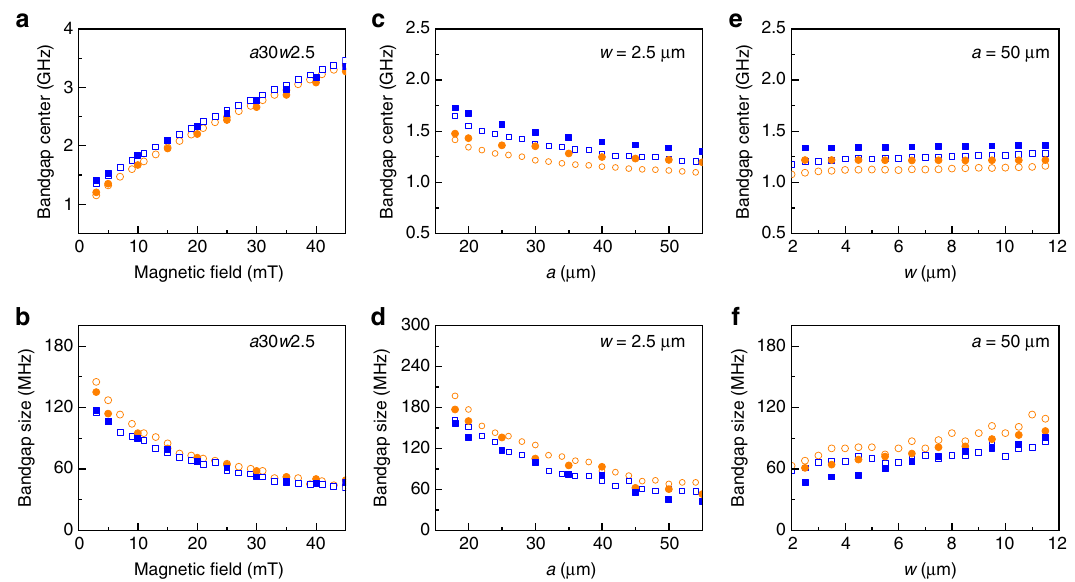
Fig. 8 Magnonic band structure tuning. a – f Measured (empty symbols) and simulated (solid symbols) positions and widths of the fi rst (circles) and second (squares) bandgaps of bicomponent CoFeB/YIG magnonic crystals as a function of a , b magnetic bias fi eld, c , d lattice constant, and e , f CoFeB stripe